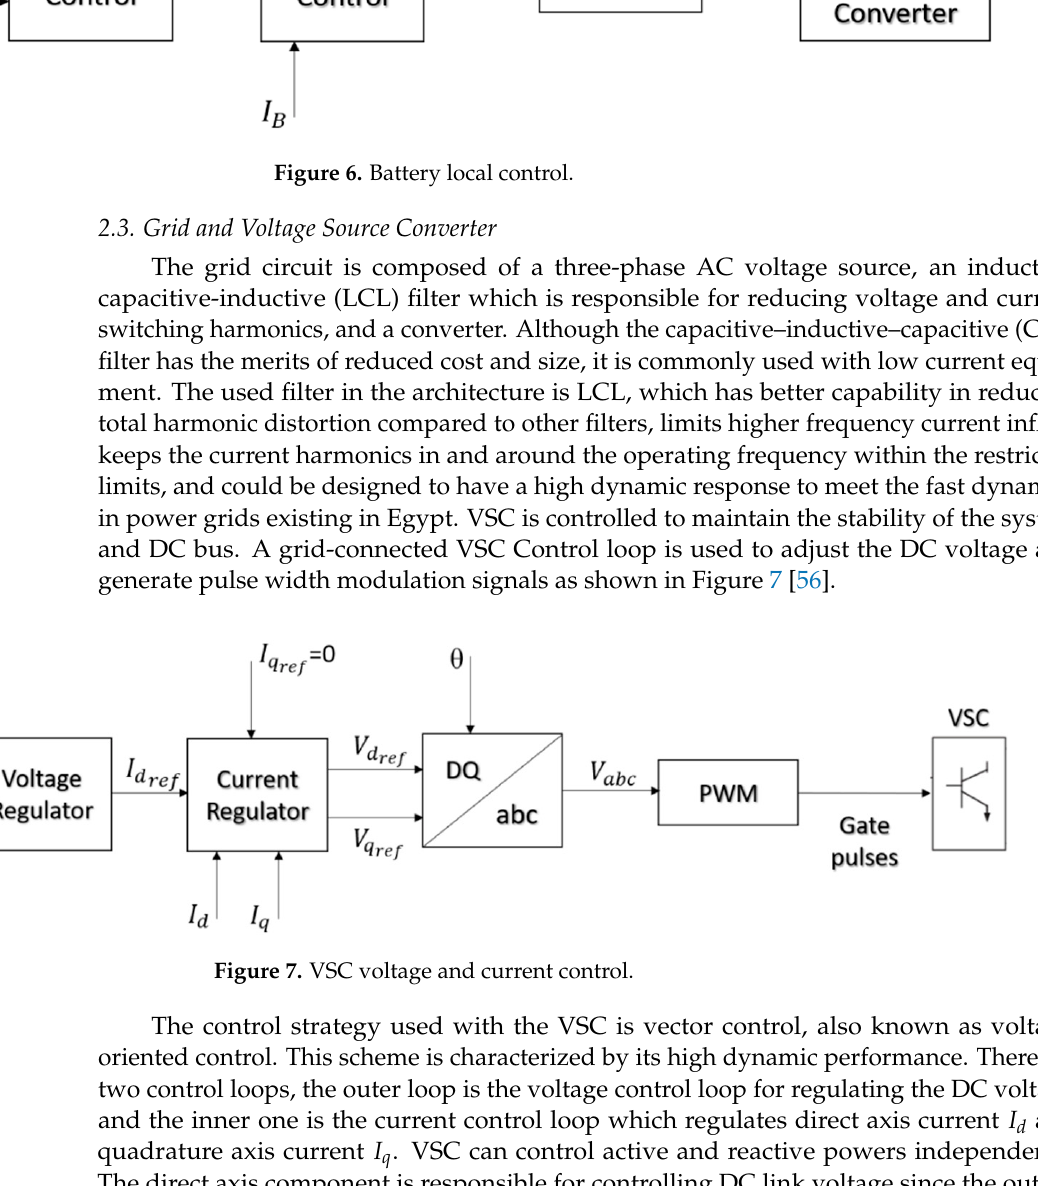
Figure 5. Equivalent circuit of battery.